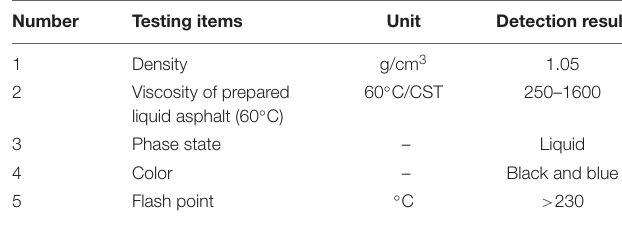
TABLE 2 | Technical indices of PR-JW03A cold patching asphalt